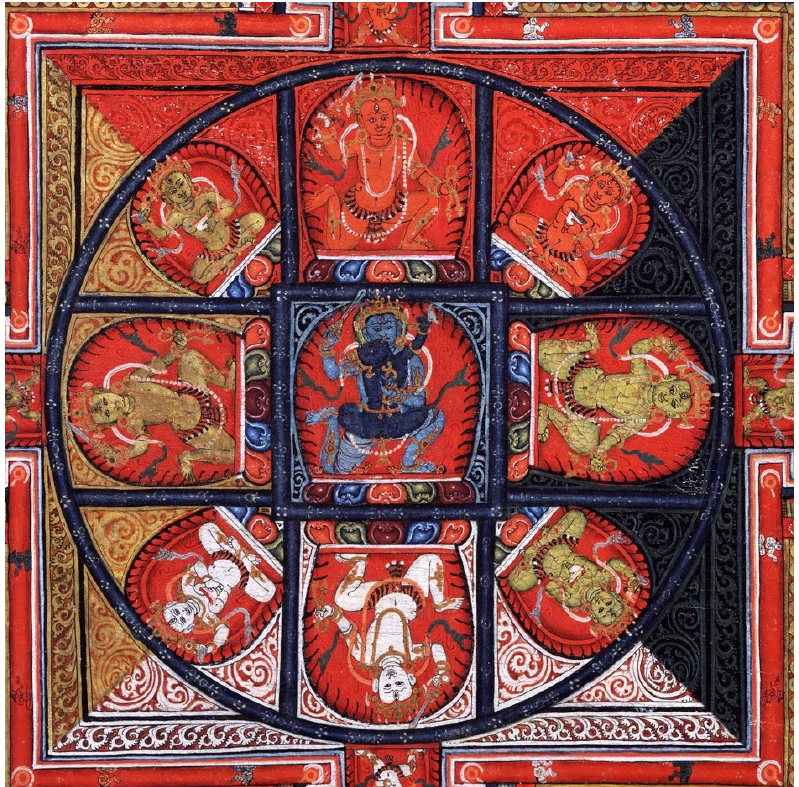
Figure 2. Ca ṇḍ amah ā ro ṣ a ṇ a mandala . This portrayal is slightly different from what is prescribed in the Ca ṇḍ amah ā ro ṣ a ṇ a Tantra ; the deities are rotated 90 degrees clockwise. Clockwise from Top left: Pi ś unavajr ī , R ā gavajr ī , Ī r ṣ y ā vajr ī , Moh ā vajr ī . (Himalayan Art Resource, Item 90915).